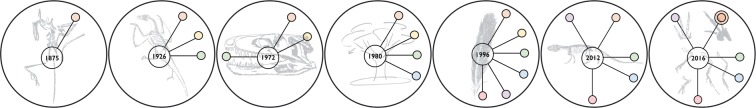

Owen (1875) founds the BAND research program but Heilmann (1926) brings it to prominence. However, even in the current era (during something of a heyday of fossil discovery), and despite the frequent proposal of speculative postulates by Feduccia (1980, 1996, 2012), no protective belt of empirical corroboration grows around the core commitment that birds are not dinosaurs, they are descended from some other group of more basal archosaurs instead. Prior postulates are repeated but neither corroborated nor extended. Interestingly, in recent work (Feduccia 2016), Owen’s initial postulate that birds and dinosaurs only look similar via convergence develops something of its own protective belt, constituted by the further claim that the threat of convergence prevents cladistics from ever settling the question of avian origins.